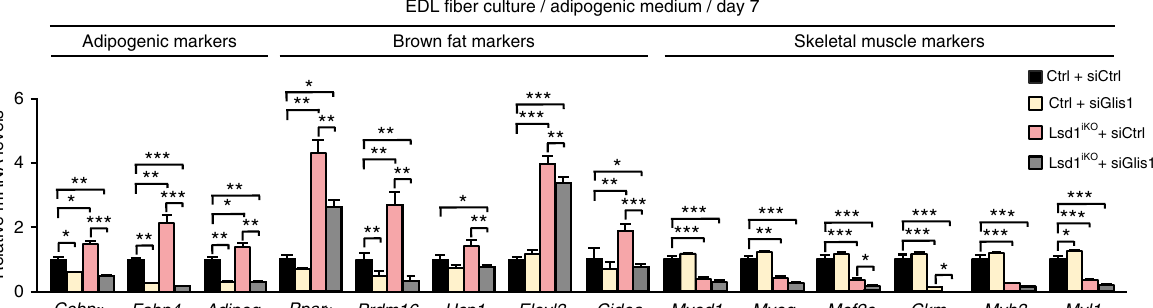
Fig. 6 Lsd1 represses expression of the pro-adipogenic factor Glis1. a ChIP-qPCR analyses using antibodies directed against Lsd1, REST corepressor 1 (Rcor1), histone deacetylase 1 (Hdac1), dimethylated histone 3 lysine 4 (H3K4me2), or rabbit immunoglobulin G (rIgG) in control (Ctrl) and LSD1(OE) C2C12 cells (left panel), or Lsd1 inhibitor-treated [Lsd1(i)] C2C12 cells (right panel) differentiated for 1 day in adipogenic medium. Immunoprecipitated chromatin was quanti fi ed by qPCR using primers fl anking Lsd1-binding sites at the promoter of Glis1 gene. b qRT-PCR analyses showing relative transcript levels of Glis1 in Ctrl, LSD1(OE), Lsd1 knockdown [Lsd1(KD)], and Lsd1(i) C2C12 cells (left panel), or Ctrl, LSD1-GFP, Lsd1 iKO , and Lsd1(i) satellite cells (right panel) differentiated for 1 day in adipogenic medium. Signi fi cance was calculated by two-tailed Student ’ s t -test. c Western blot analysis showing protein levels of Glis1 in Ctrl, Lsd1 iKO , and Lsd1(i) satellite cells differentiated for 1 day in adipogenic medium. d – f Analyses of Ctrl and Lsd1 iKO EDL fi ber culture cells transfected with control (siCtrl) or siRNA directed against Glis1 (siGlis1) and differentiated for 7 days in adipogenic medium. d qRT-PCR analyses showing relative transcript levels of Glis1 and Lsd1 , e ORO staining, and f qRT-PCR analyses showing relative transcript levels of indicated genes. ( a , d , f : n = 3, b : n = 6; mean + SEM, * p < 0.05, ** p < 0.01, *** p < 0.001; scale bars: e : 50 µ